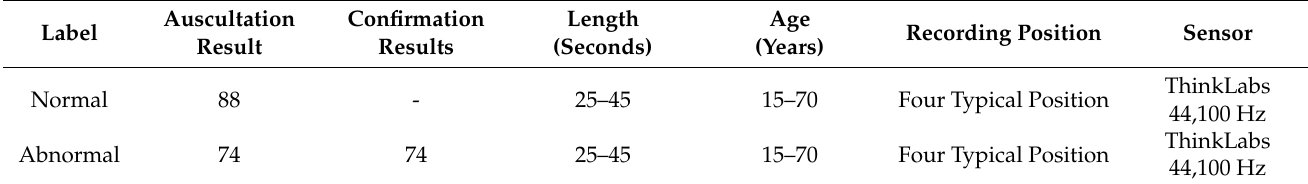
Table 2. Data set used in verification tests at Ankara City Hospital.